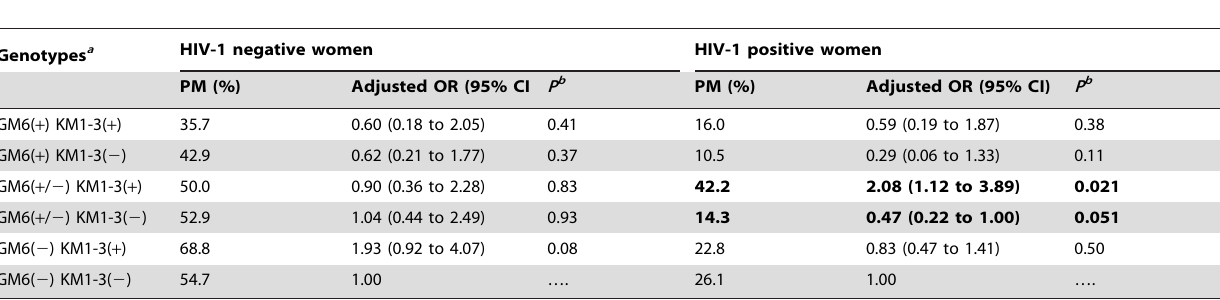
Table 4. Effect of combined GM6 and KM1-3 genotypes on the risk for PM in HIV-1 negative and positive women.